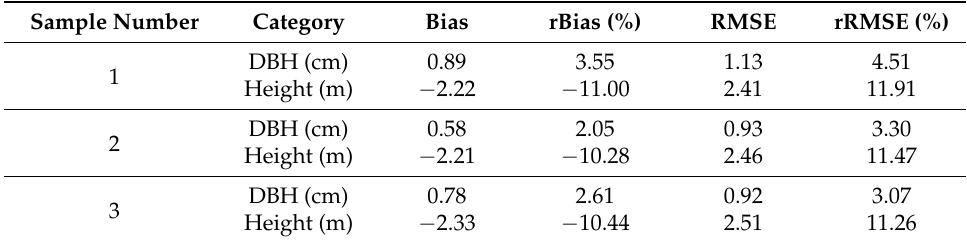
Table 3. Comparison of the DBH and height estimates by utilizing image-based estimates and field